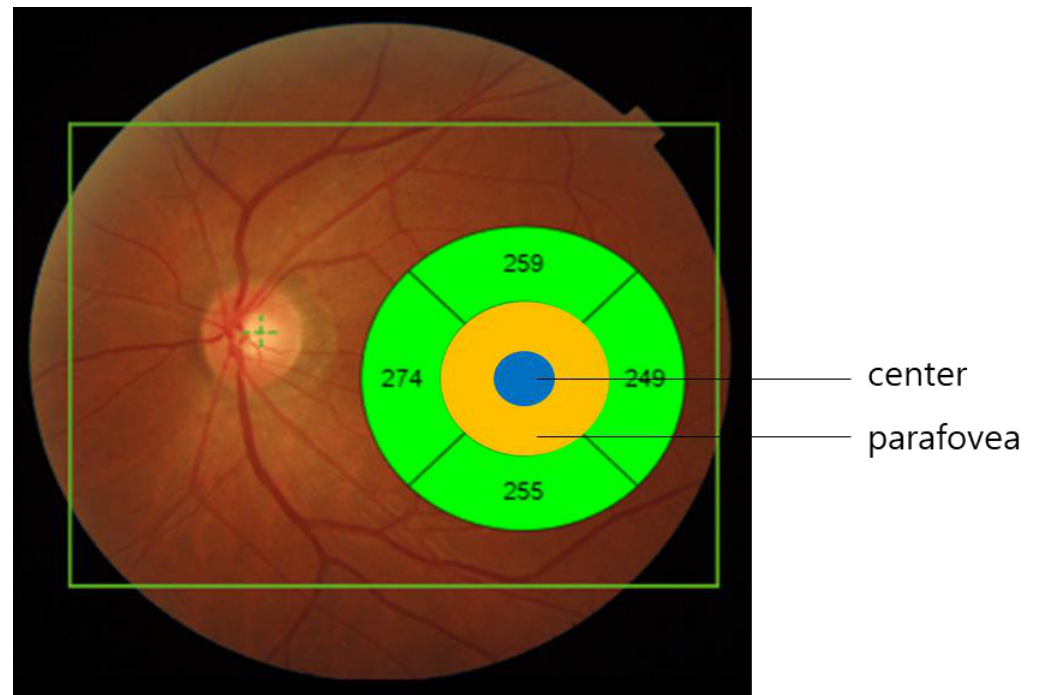
Figure 2. The inner and outer rings with a diameter of 1 and 3 mm around the fovea, respectively, were considered for evaluation. The parafoveal retinal thickness, parafoveal RNFL thickness, and parafoveal GC-IPL thickness were calculated as the average value of outer rings in each layer.